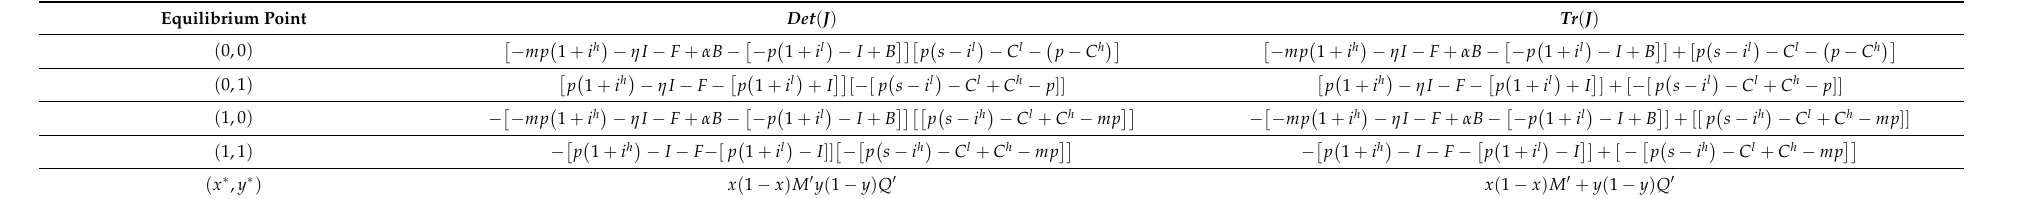
Table 6. The value and trace of the Jacobian matrix at each evolutionary equilibrium point for active online lending platform. Equilibrium Point